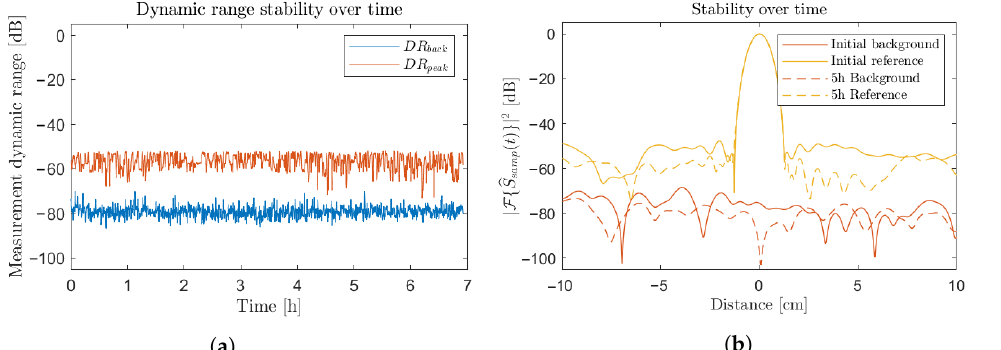
Figure 7. ( a ) Dynamic range stability over time; ( b ) reference and background signals taken right after the calibration and after 5 h of